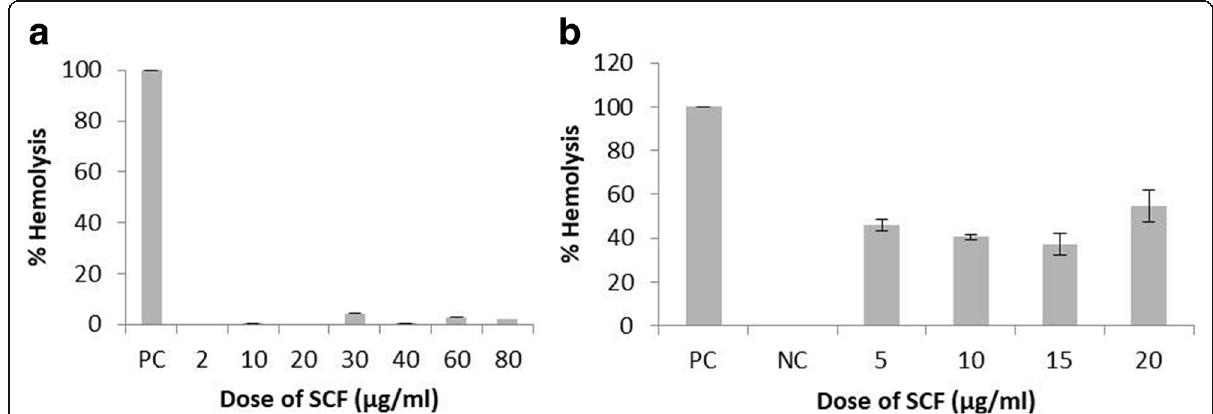
Fig. 7 a Hemolytic activity of SCF on human RBCs. Hemolytic activity of various dosages of SCF were tested on human RBCs. PC = 1% SDS; NC = 0.85% saline. SCF showed negligible hemolysis of human erythrocytes in vitro ( n = 3 replicates). b Hemolytic activity of SCF on goat RBCs. PC =